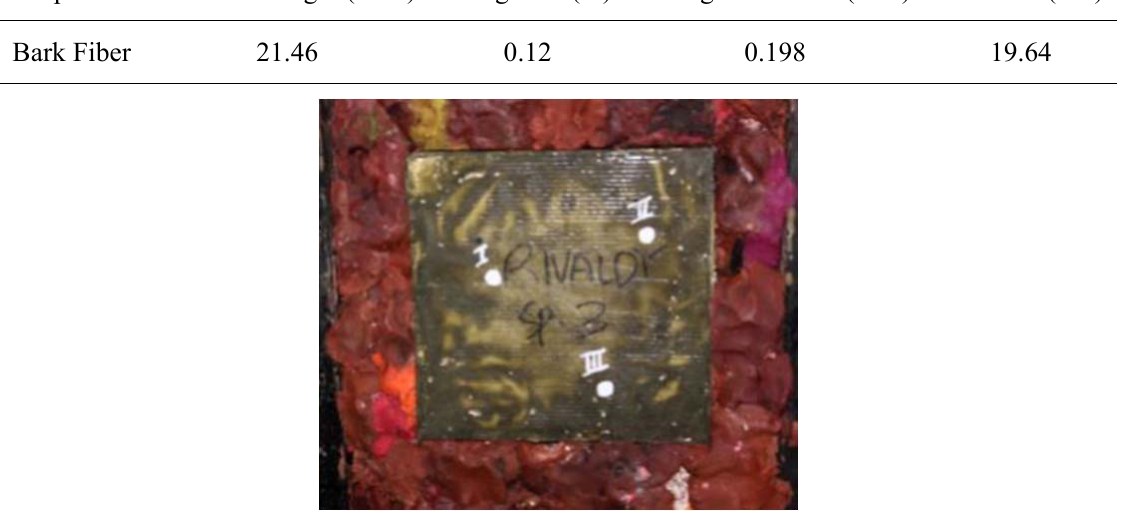
Figure 3. Specimen Ballistic Testing